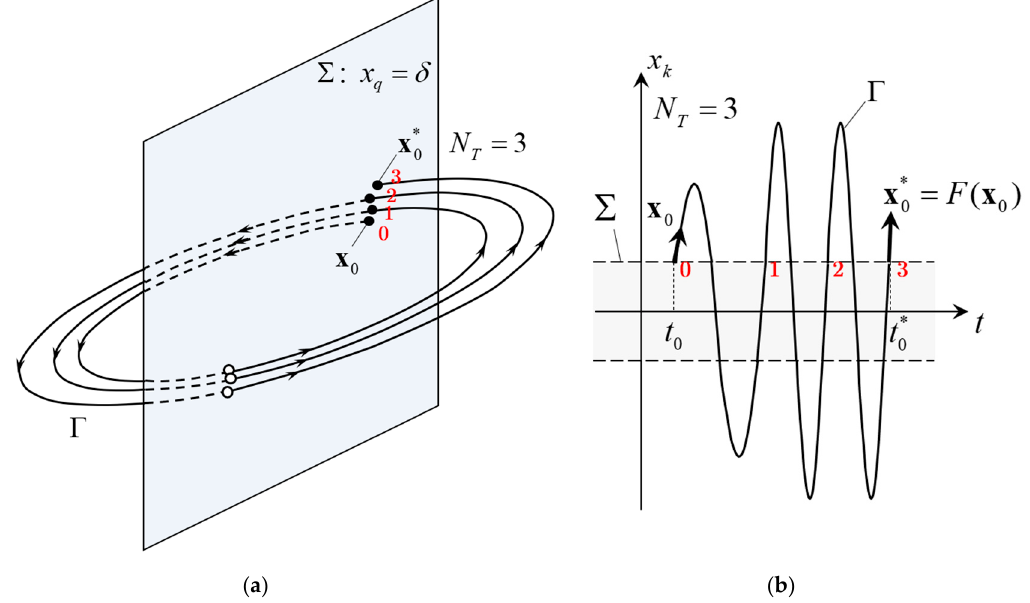
Figure 5. Illustration of the N T -th time return mapping. ( a ) is depicted in state space and ( b ) is depicted on the plane of the freeplay state vs. time. The parameter N T = 3 is given as an example.